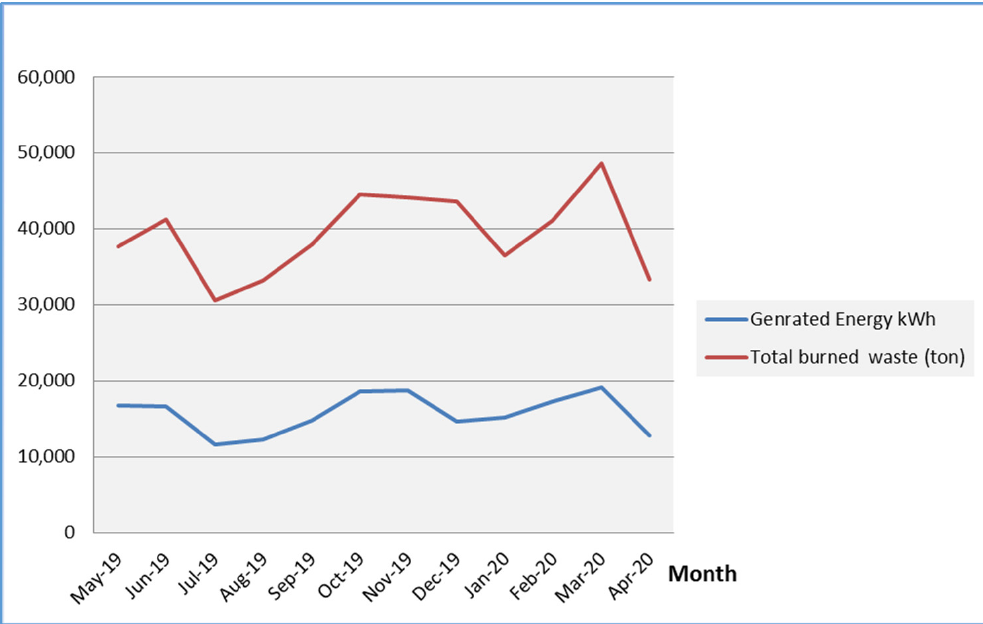
Figure 6. Waste-to-energy production (source AASWMA, 2020).